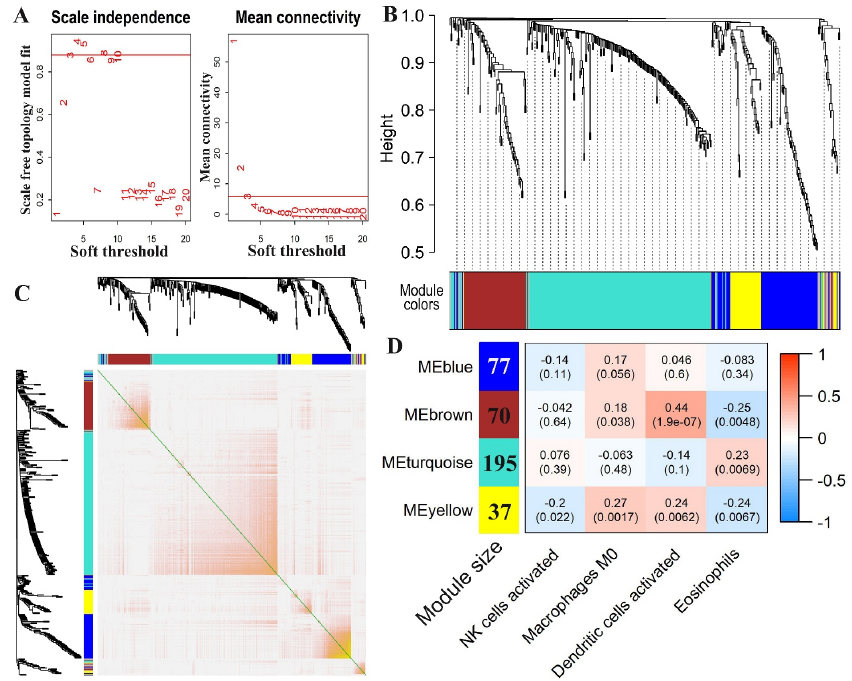
Figure 4. Co-expression networks constructed by WGCNA. ( A ) Selection of appropriate soft thresh- old for network topology analysis. ( B ) Hierarchical clustering dendrogram of co-expressed genes identified in the module. The dendrogram was created via unsupervised hierarchical clustering of genes. Each module was presented in a specific color. ( C ) Heatmap of co-expression gene modules based on TOM dissimilarity. The level of similarity is represented by the intensity of the yellow in the heatmap, where the yellow-yellow color indicates an increase in similarity. ( D ) Heatmap of cor- relations between immune cell abundances and module eigengenes. An eigengene was defined as the first principal component of the expression matrix of the corresponding module, which could be considered a representation of the gene expression profiles within a module. Each row corre- sponds to a module and each column corresponds to the abundance of one subtype of immune cells. Each cell has a correlation coefficient and its associated p -value in parentheses. Light blue represents negative correlation and light red represents positive correlation. Dark colors in the heatmap repre- sent genes that are highly correlated in the module. The size of each module is shown in the left column of the heatmap.